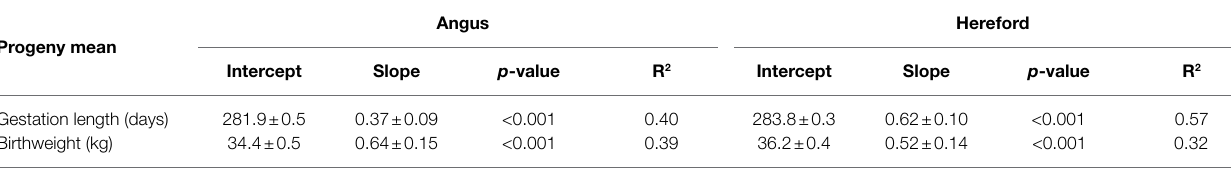
TABLE 3 | Estimates of regression coefficients (intercept and slope) of least-squares means of beef-cross-dairy progeny groups for birth traits (gestation length and birthweight) on corresponding sire EBV, for 30 Angus and 34 Hereford sires.